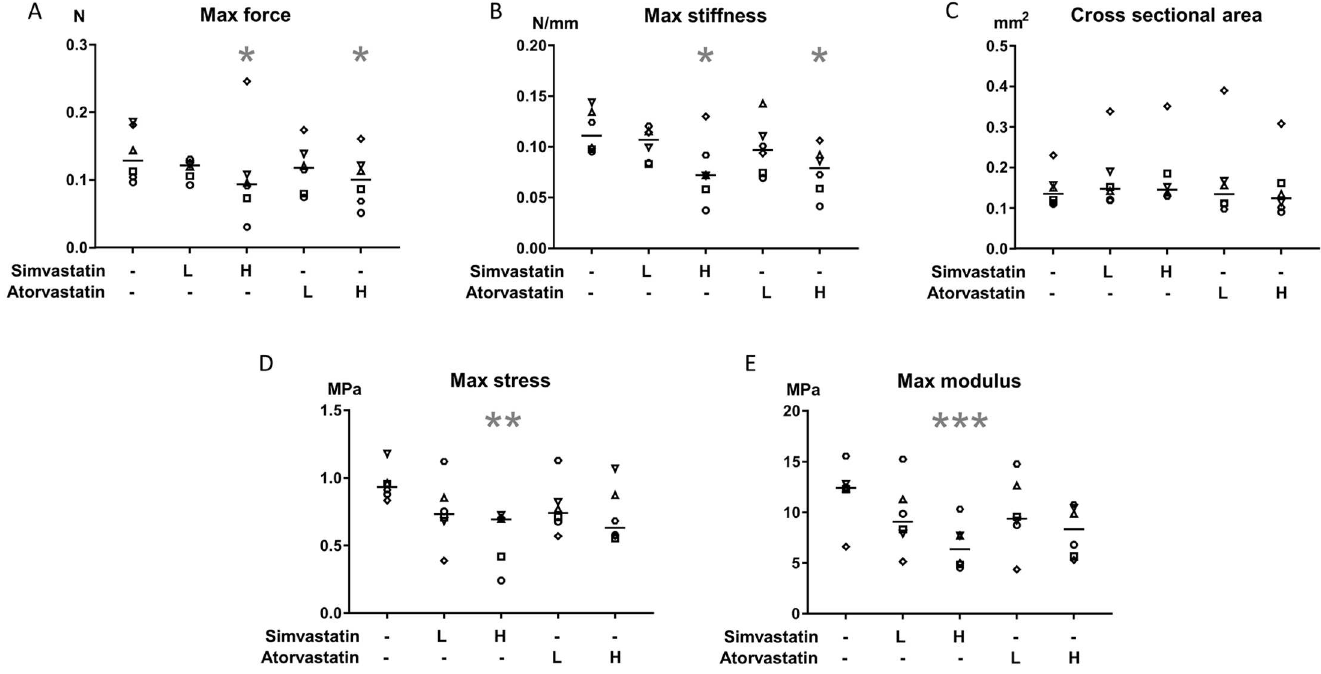
Fig 2. Construct mechanical data. Maximum force, maximum stiffness, cross sectionalarea, maximum stress and maximum modulusof tendon constructs with or without statin treatment for 7 days. Low dose (L) statin treatment corresponds to 0.05 μ M(simvastatin or atorvastatin) and high dose (H) corresponds to 0.5 μ M. Significant changesfrom DMSO-control are indicatedby * (p < 0.05), ** (p < 0.01)or *** (p < 0.001). The line represents median value. n = 6 different donor-specific cell lines, where each symbol represent the mean value from three replicates from one cell line. The force, stiffness, stress and modulus were all reducedafter 7 days of high dose simvastatin treatment. High dose treatment with atorvastatinalso reducedthe force and stiffness and tended to reducethe maximum modulus(p =